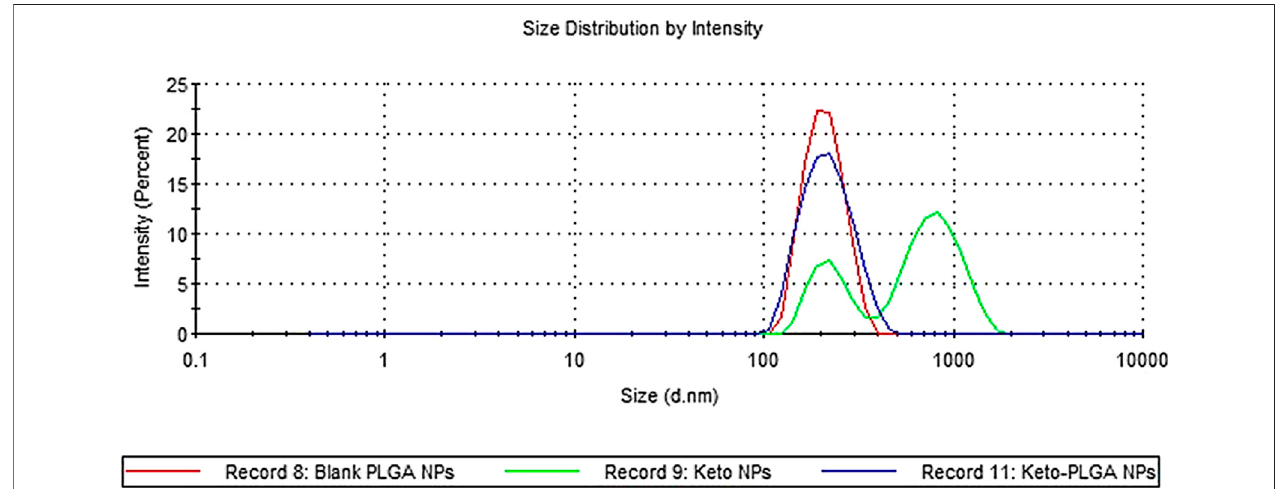
FIGURE1 | Particle size distribution by intensity. Blank PLGANPs contain no drug, keto PLGA NPscontain12.5% ketoconazoleand 87.5% PLGA, and keto NPs contain 100% ketoconazole.